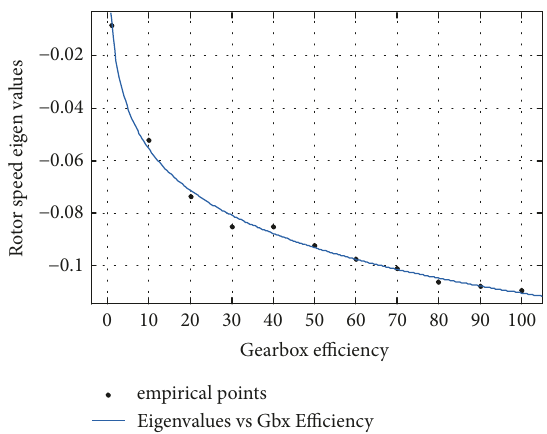
Figure 9: The variations of the eigenvalues of the dynamics matrix of the rotor speed with respect to the gearbox